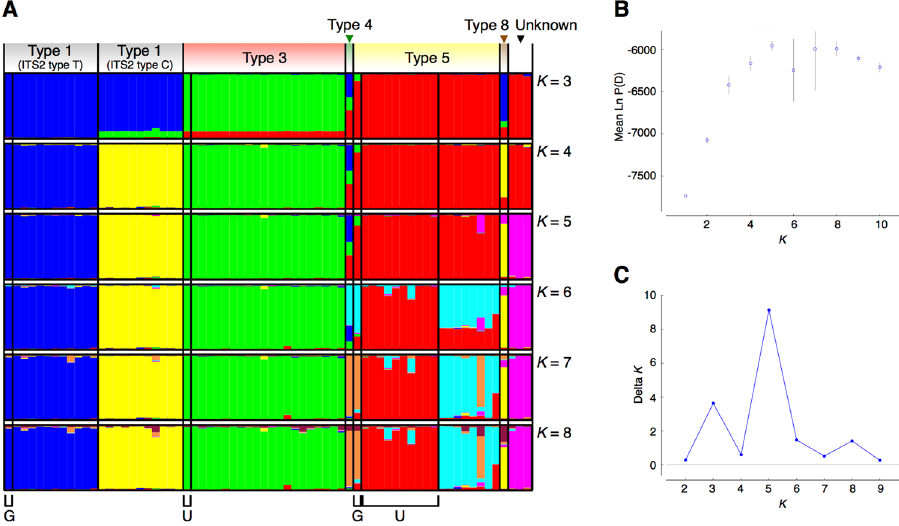
Figure 2. Population genetic assessment using STRUCTURE suggests five probable genetic clusters within just the pair of sites we surveyed. These clusters reflect primarily the mtORF (including ITS2) types. The Evanno method was used to decide the probable number of genetic clusters. ( A ) Each bar plot shows the possible membership of genetic clusters for each MLL. Those ranged from three to eight ( K = 3 to K = 8), with K = 5 being optimal. G: MLLs of samples collected from the western coast of Okinawa Island, used for Illumina sequencing, U: MLLs of samples collected at Ueno, Miyako Island. Samples of other MLLs were collected at Yoshino, Miyako Island. ( B and C ) The model criterion of choice to detect the most probable number of genetic clusters ( K = 1 to K = 10) across 10 iterations per K (the assumed number of clusters). Graphs of ( B ) mean log probability (Ln P(D)) and ( C ) Δ K values based on the rate of change in Ln P ( D ) between successive K values ( K = 2 to K = 9) for detecting the most probable number of K